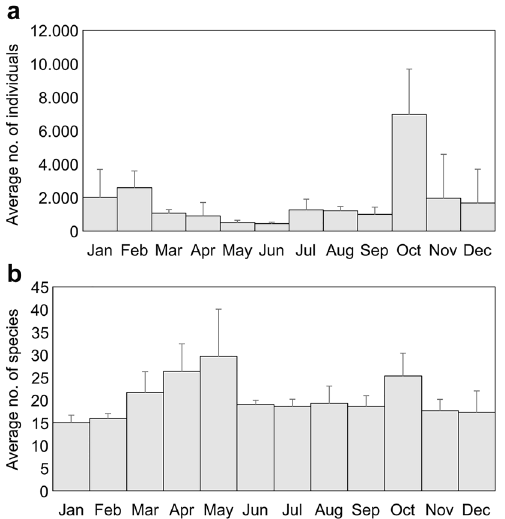
Figure 1. Seasonal change in the average number of ( a ) individuals and ( b ) species of birds in the rice fields of midwestern South Korea. The error bars represent the standard deviation. The sample size of each bar was 36, which is the number of surveys (once per month for 3 years, from January 2014 to December